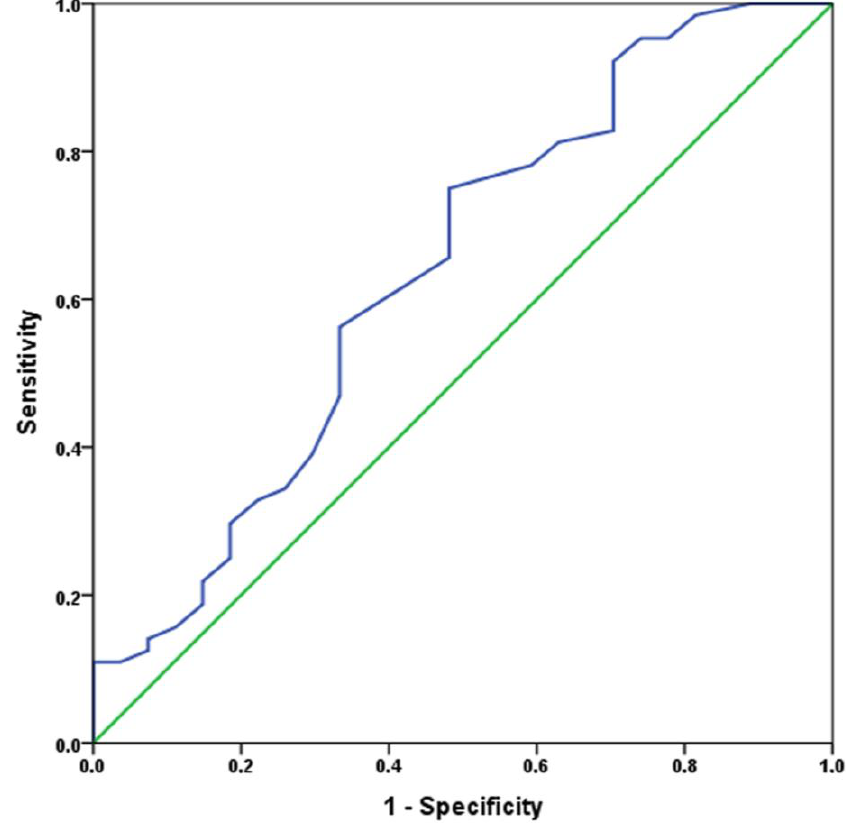
Figure 4. The area under the curve is 0.64 (CI 0.51 – 0.77), p =